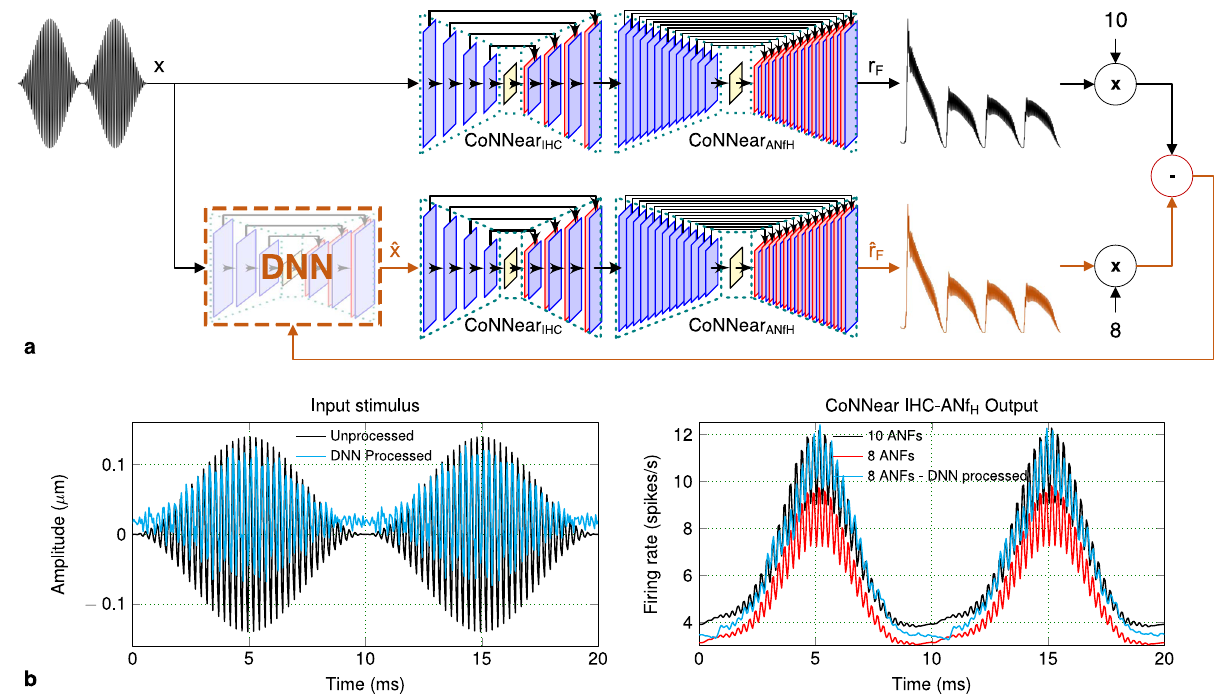
Fig. 8 Using CoNNear for backpropagation. a The audio-signal processing DNN model is trained to minimise the difference between the outputs of the two CoNNear IHC – ANF models (orange pathway). b When processed by the trained DNN model, the input stimulus results to a fi ring rate output for the second model that closely matches the fi ring rate of the fi rst